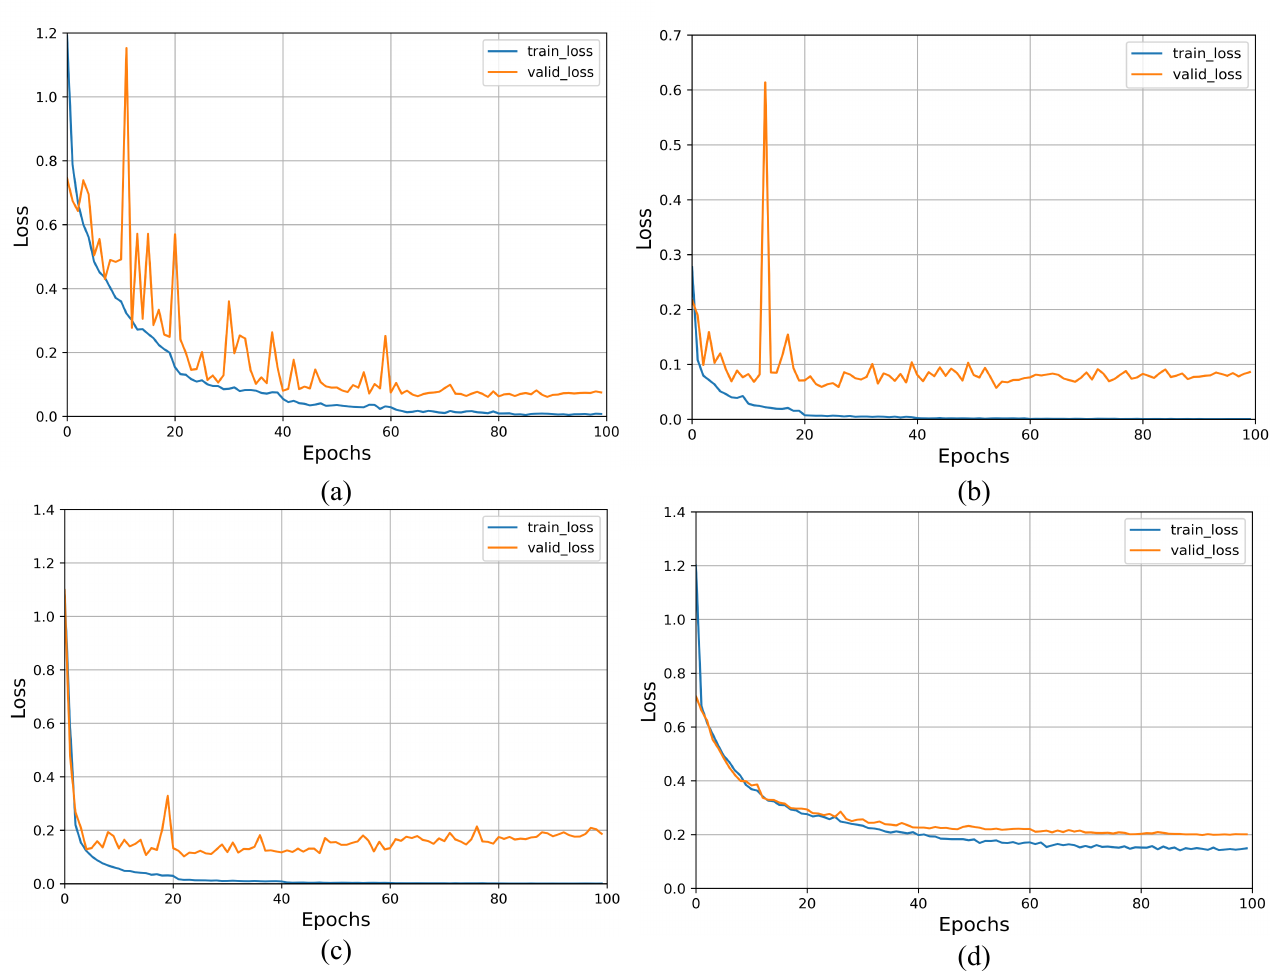
Figure 7. Loss curves of the original VGG19 and the improved VGG19. ( a , b ), respectively, represent the loss curves of the improved VGG19 on the COVIDx CT-2A and the integrated CT scan dataset. ( c , d ) represent the loss curves of original VGG19 on the COVIDx CT-2A and the integrated CT scan dataset. Table 3. Comparison of parameter numbers and complexity of VGG19 and the proposed